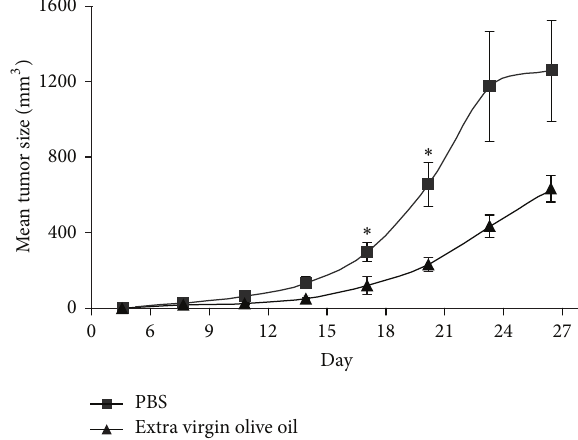
Figure 3: In vivo growth inhibitory effects of extra virgin olive oil on HCT 116 human colon cancer cells. HCT 116 cells were injected subcutaneously into athymic mice (10 mice for EVOO-treated groups and 10 mice for PBS-treated controls), and one-week later 200 𝜇 L intraperitoneal injections of PBS 1X or extra virgin olive oil (1mL/kg) were performed, as described in Materials and Methods. Tumor size was then routinely monitored by means of a common caliper. Results are reported as means ± SD. ∗ 𝑃 < 0.05 (two-tailed Student’s 𝑡 -test), as compared to PBS-treated